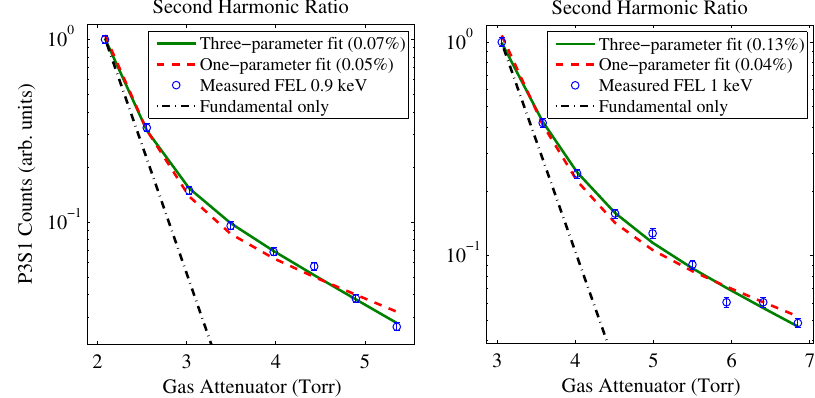
FIG. 8. We measure the harmonic component by varying the gas attenuator strength for 0.9 keV (left) and 1 keV (right) fundamental photon energies. Blue circles show experimental data, red dotted lines show one-parameter fits using the nominal attenuation lengths, and solid green lines show three-parameter fits to both the harmonic content and attenuation lengths. The black dot-dashed line shows the expected attenuation of the fundamental only. We find approximately 0.05%–0.1% second harmonic